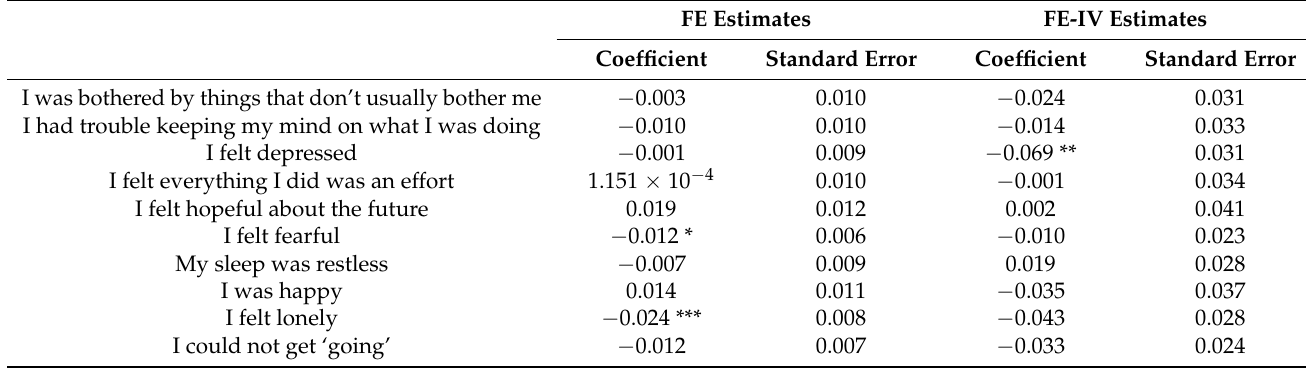
Table 5. Impact of the NRSPI pensions on mental health outcomes by each item.